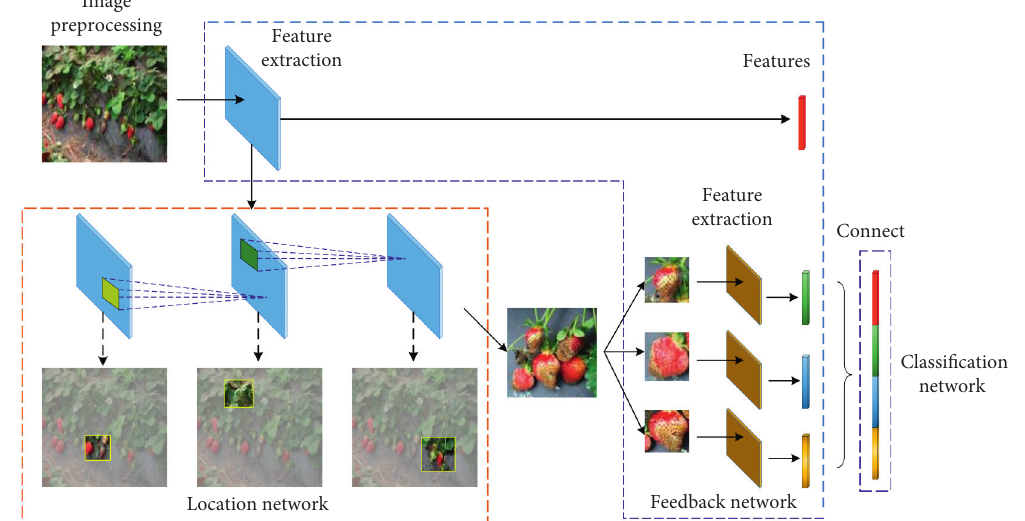
Figure 5: Extraction of deep network structure for strawberry common disease recognition.